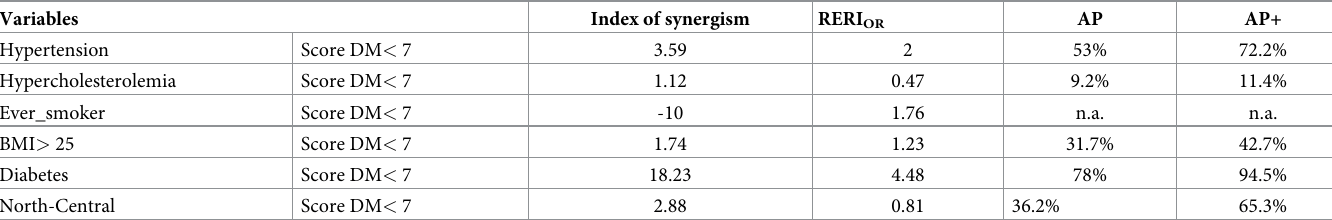
Table 5. Index of synergy and other measures of additive